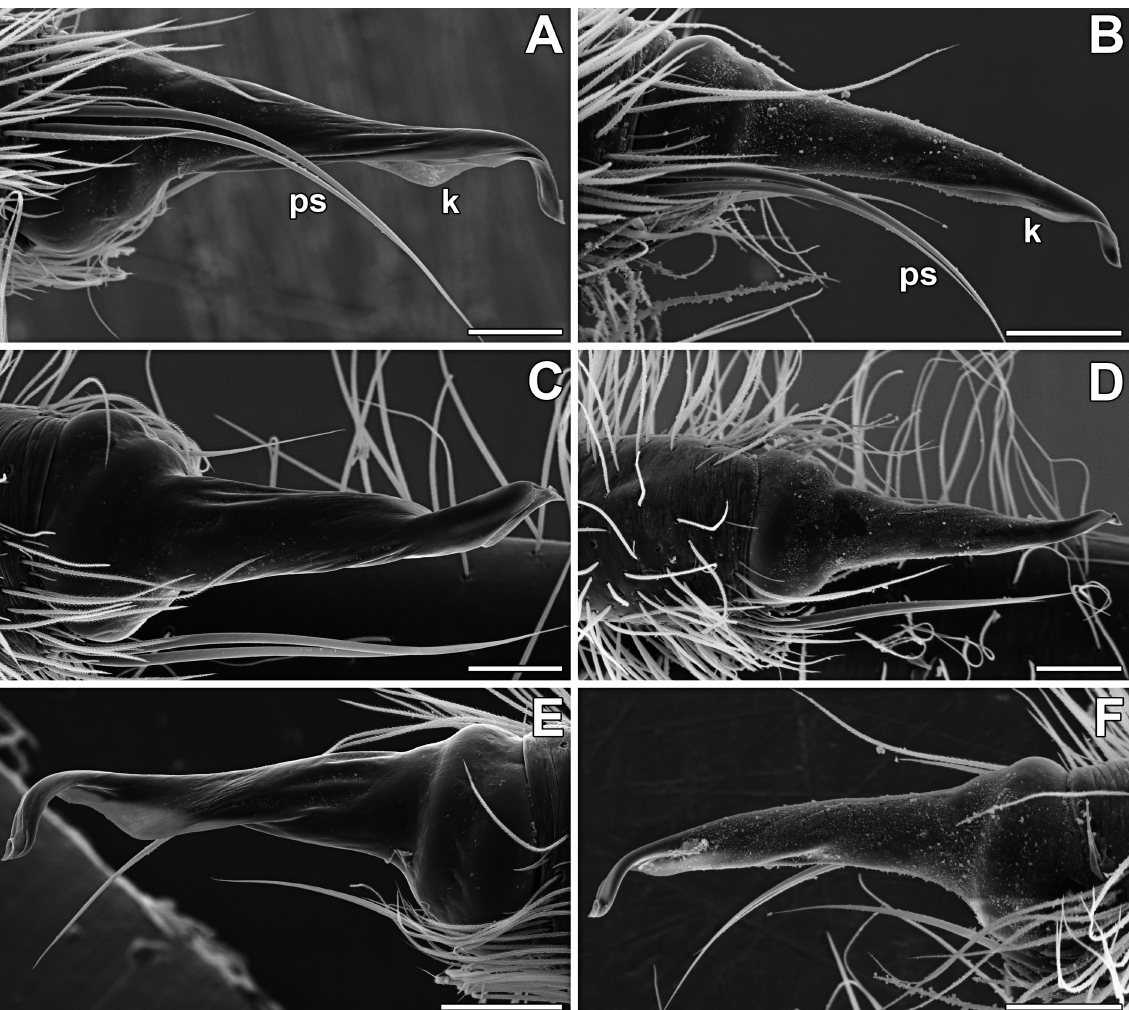
Fig. 5. A, C, E . Filistata betarif sp. nov., paratype, ♂, from Israel, Tinshemet cave, (MACN-Ar 41793), left pedipalp. B, D, F . Filistata insidiatrix (Forsskål, 1775), ♂, from Spain, Mallorca (MACN-Ar 42347), right pedipalp, mirrored. A–B . Prolateral view. C–D . Dorsal view. E–F . Retrolateral view. Abbreviations: k = embolic keel; ps = prolateral setae. Scale bars = 0.1